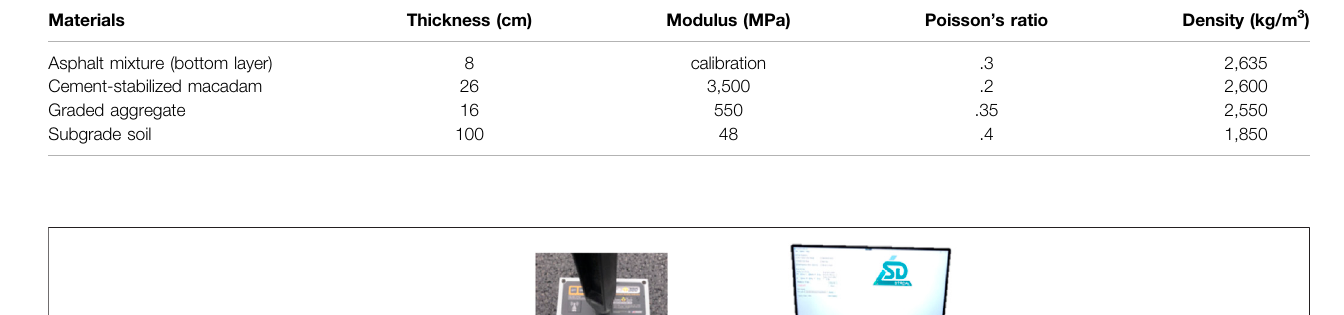
Frontiers in Materials |